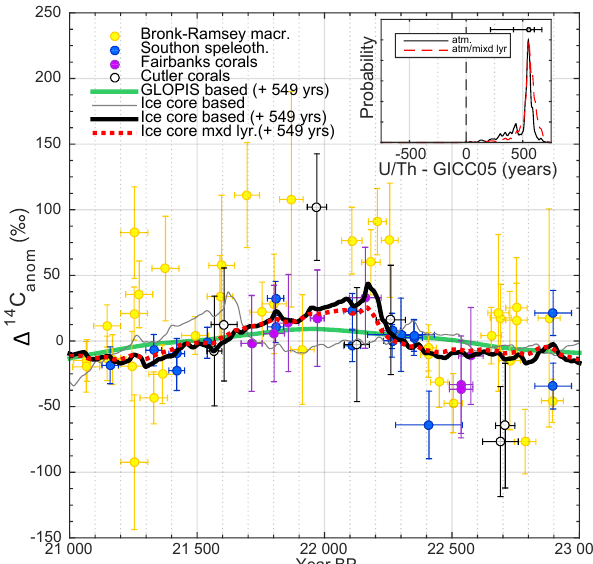
Figure 10. Synchronization of 10 Be and 14 C around the Laschamp event. The black lines encompass the modeled (cid:49) 14 C anomalies ( ± 1 σ ) from the ice-core data shifted by + 252 years (68.2% confi- dence interval =− 103 to 477 years) according to their best fit to the speleothem 14 C data. The green patch shows the ± 1 σ envelope of IntCal13. The blue and purple symbols show (cid:49) 14 C from Bahamas speleothem and corals, respectively. The yellow symbols show (cid:49) 14 C anomalies based on Lake Suigetsu macrofossils. All datasets have been centered to 0‰ by subtracting the error-weighted mean of each dataset. The inset shows the PDF of the inferred age dif- ferences between the ice-core data and IntCal13 (green), Lake Suigetsu (yellow), and the Bahamas speleothem (blue). The dashed blue line corresponds to age differences from the modeled mixed layer (cid:49) 14 C and the Bahamas